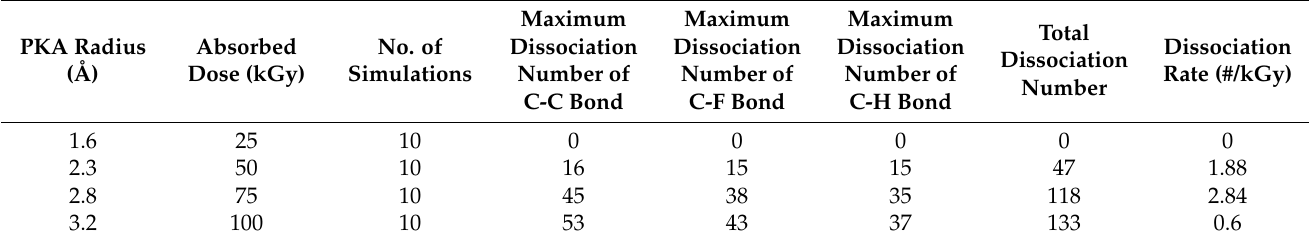
Table 3. Maximum dissociation number of each bond in 5F-PS (poly(2,3,4,5,6-pentafluorostyrene)) @ 1